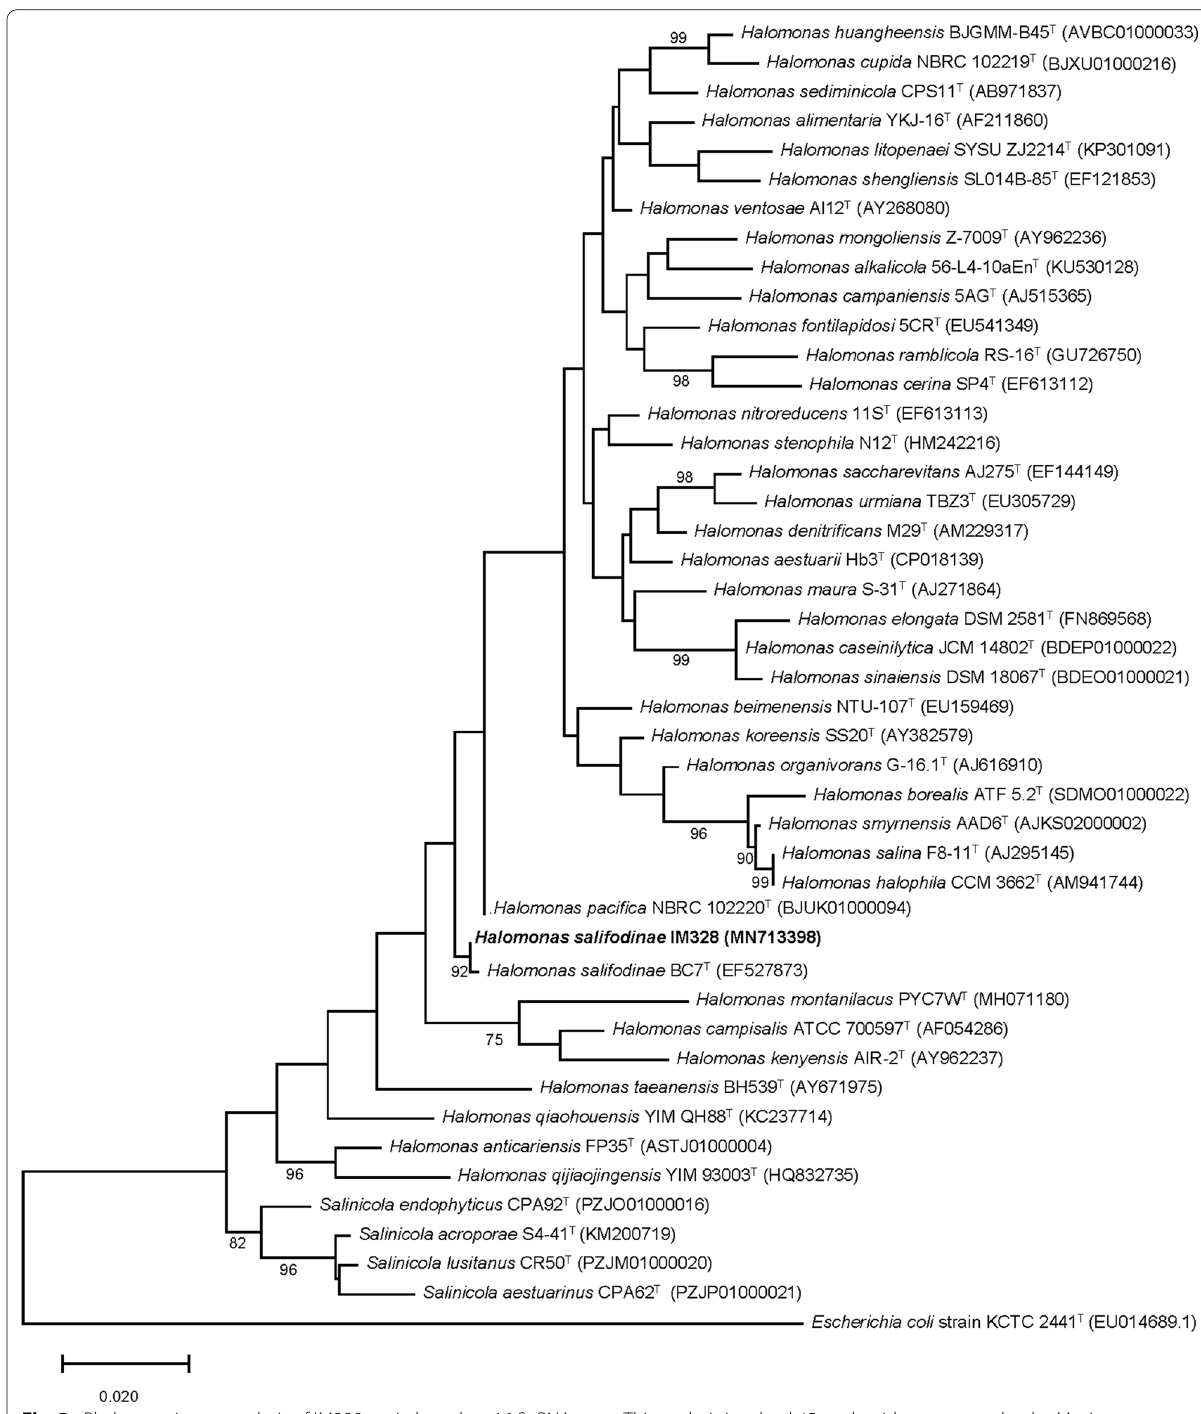
Fig. 3 Phylogenetic tree analysis of IM328 strain based on 16 S rRNA gene. This analysis involved 45 nucleotide sequences by the Maximum Likelihood method and Tamura-Nei model (Tamura and Nei 1993). E . coli strain KCTC 2441 T was the outgroup bacterium used for the root of the tree. The sequences and the sequence accession numbers were obtained from GenBank. Evolutionary analyses were conducted in MEGA X (Kumar et al. 2018). Bar, 0.02 substitutions per nucleotide